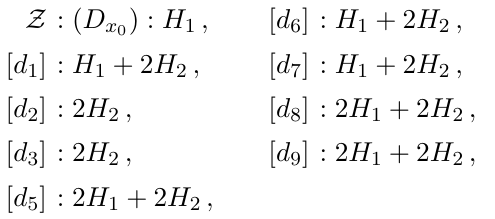
bundle choice of the base sections d